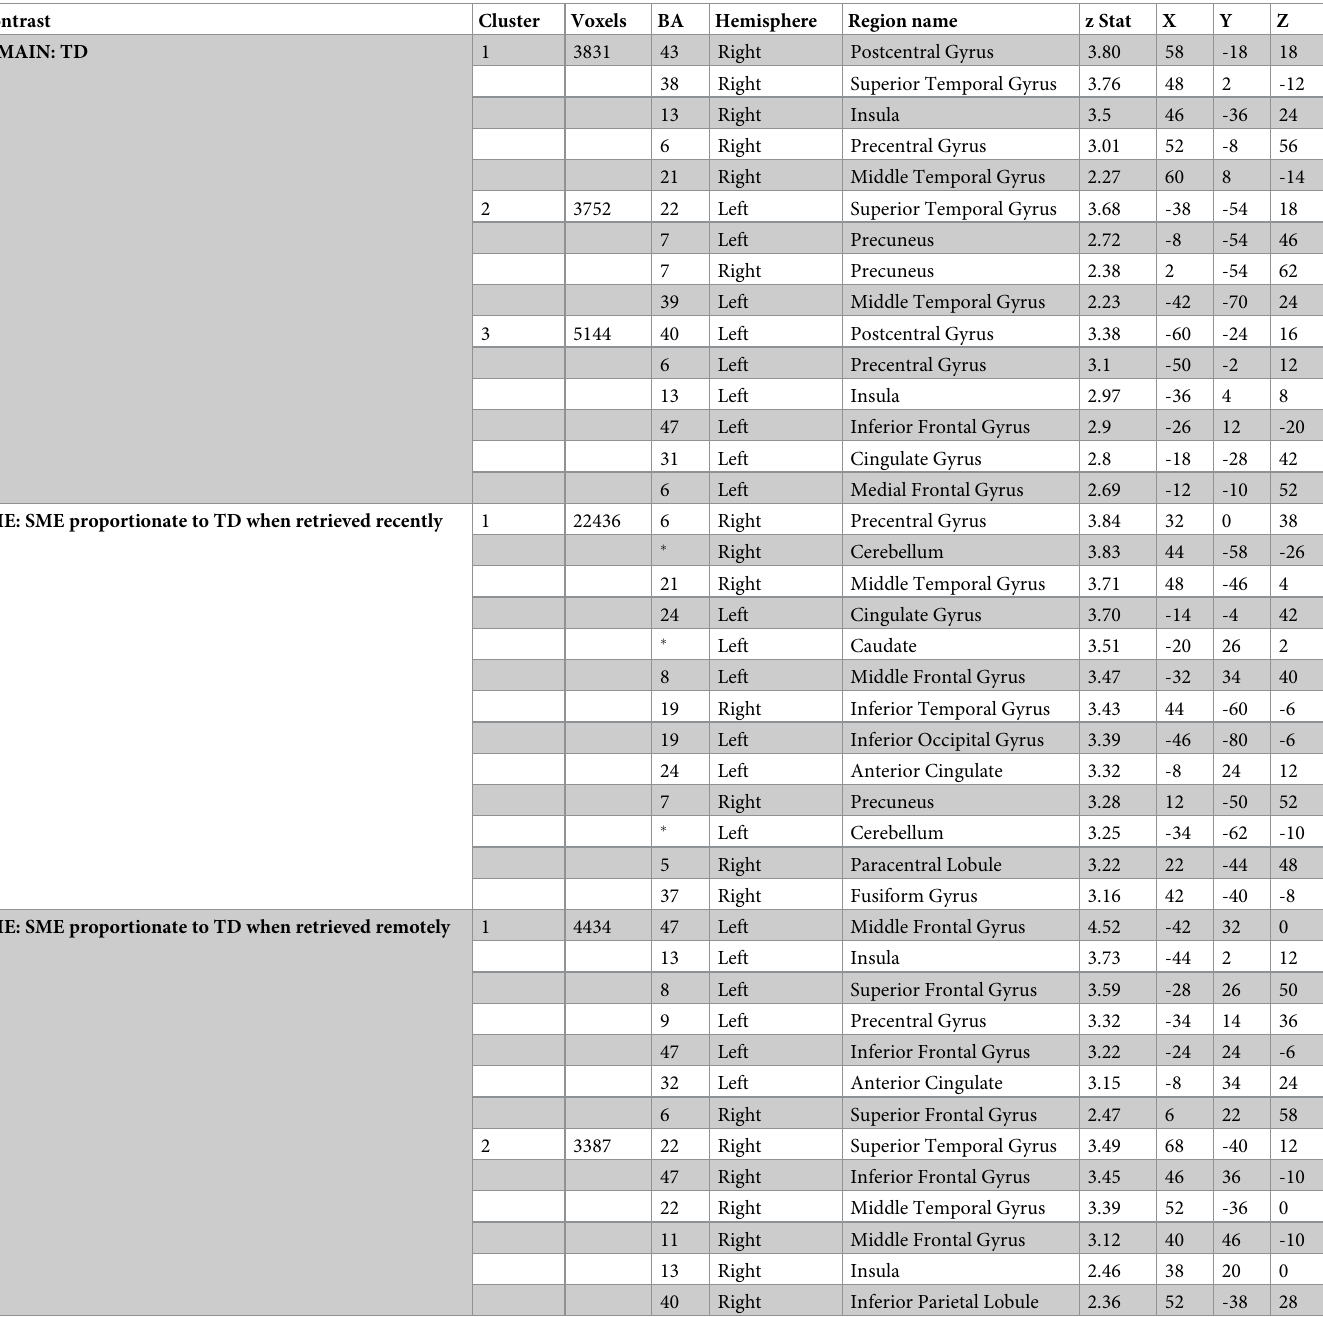
Table 3. Whole-brain activation of regions during encoding phase. Contrast